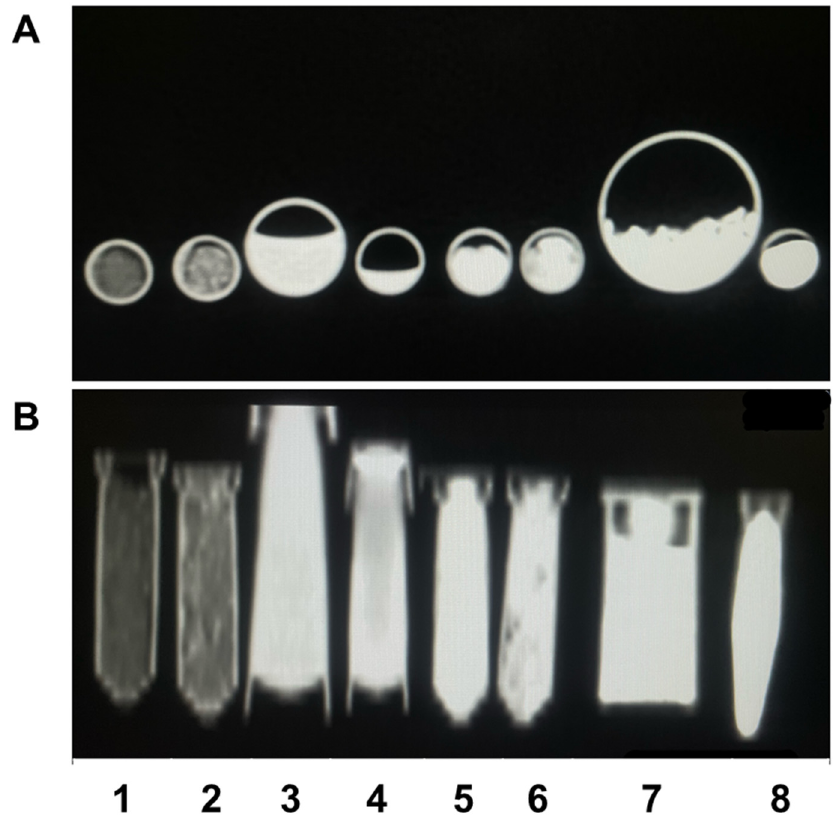
Figure 2. CT imaging showing axial section ( A ) and coronal section ( B ) of the samples Zn-HA 10% (1), Sr-HA 10% (2), HA 282 STT (3), HA 212 500 °C (4), HA 01.256 CTT 1000 °C (5), HA microspheres (6), AuNP (7), and Cu-GO (8).